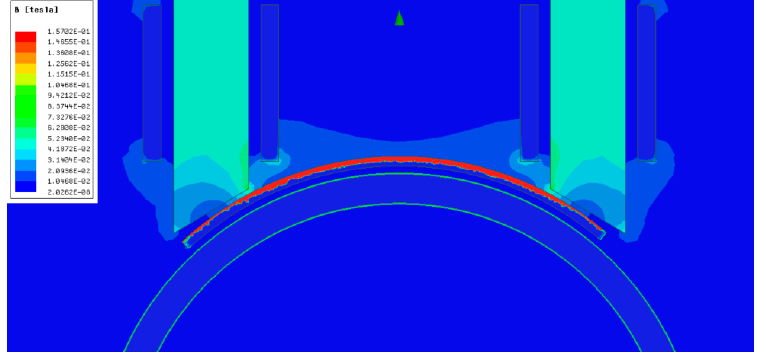
Figure 14. Magnetostrictive transducer based on the use of a magnetic core. Simulation performed at 100 kHz, 5 A.